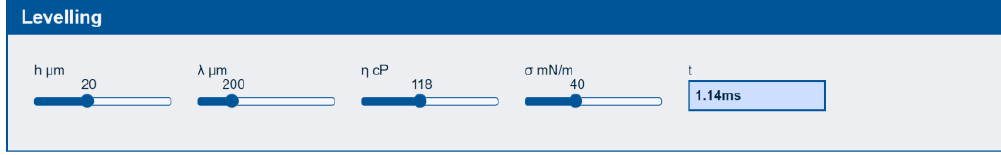
Figure 4. A 200 μm feature in a 20 µm coating levels in ≈1 ms. A well-intentioned reduction in Figure 4. A 200 µ m feature in a 20 µ m coating levels in ≈ 1 ms. A well-intentioned reduction in thickness to 10 μm would increase the time to 8-fold while defects of 240 μm wavelength would thickness to 10 µ m would increase the time to 8-fold while defects of 240 µ m wavelength would double double the time. The app is at www.stevenabbott.co.uk/practical-coatings/levelling.php. the time. The app is at